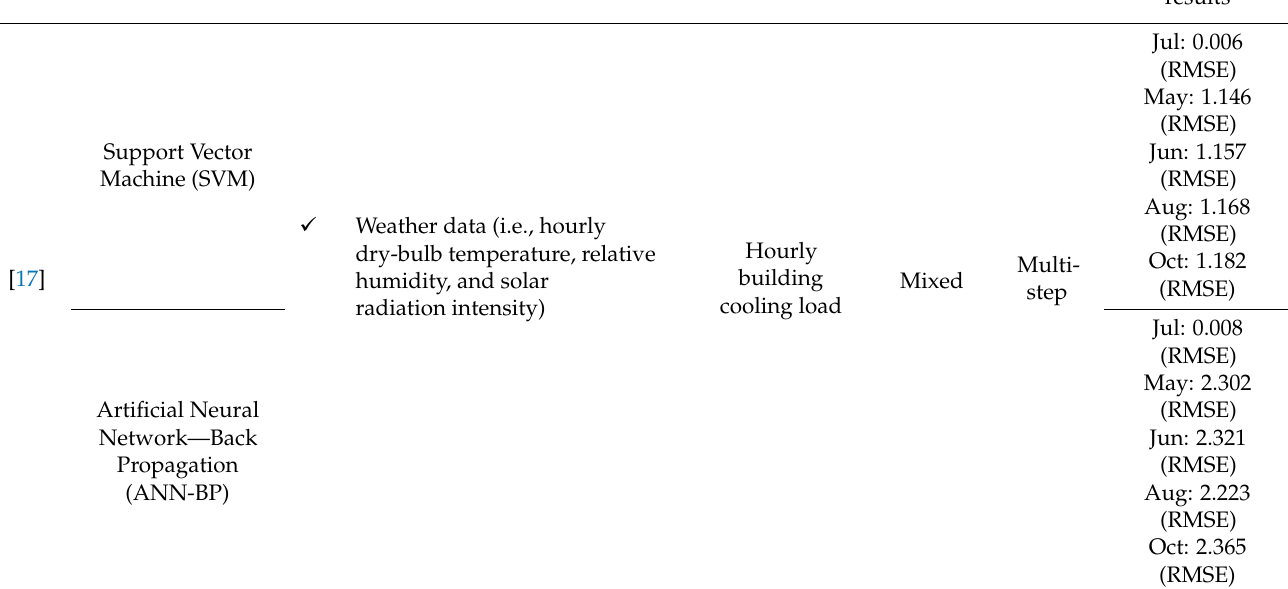
Table 1. Summary of prior research in predicting energy consumption in residential buildings.